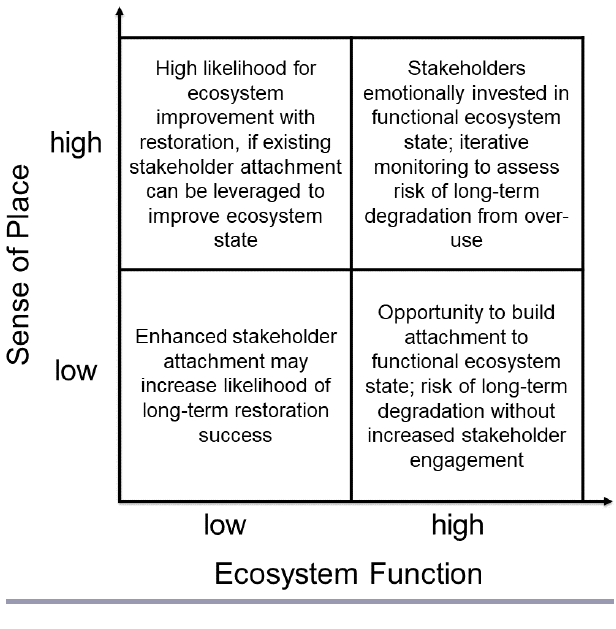
Fig. 3 . Likelihood of ecosystem improvement with restoration in coupled human-natural space.